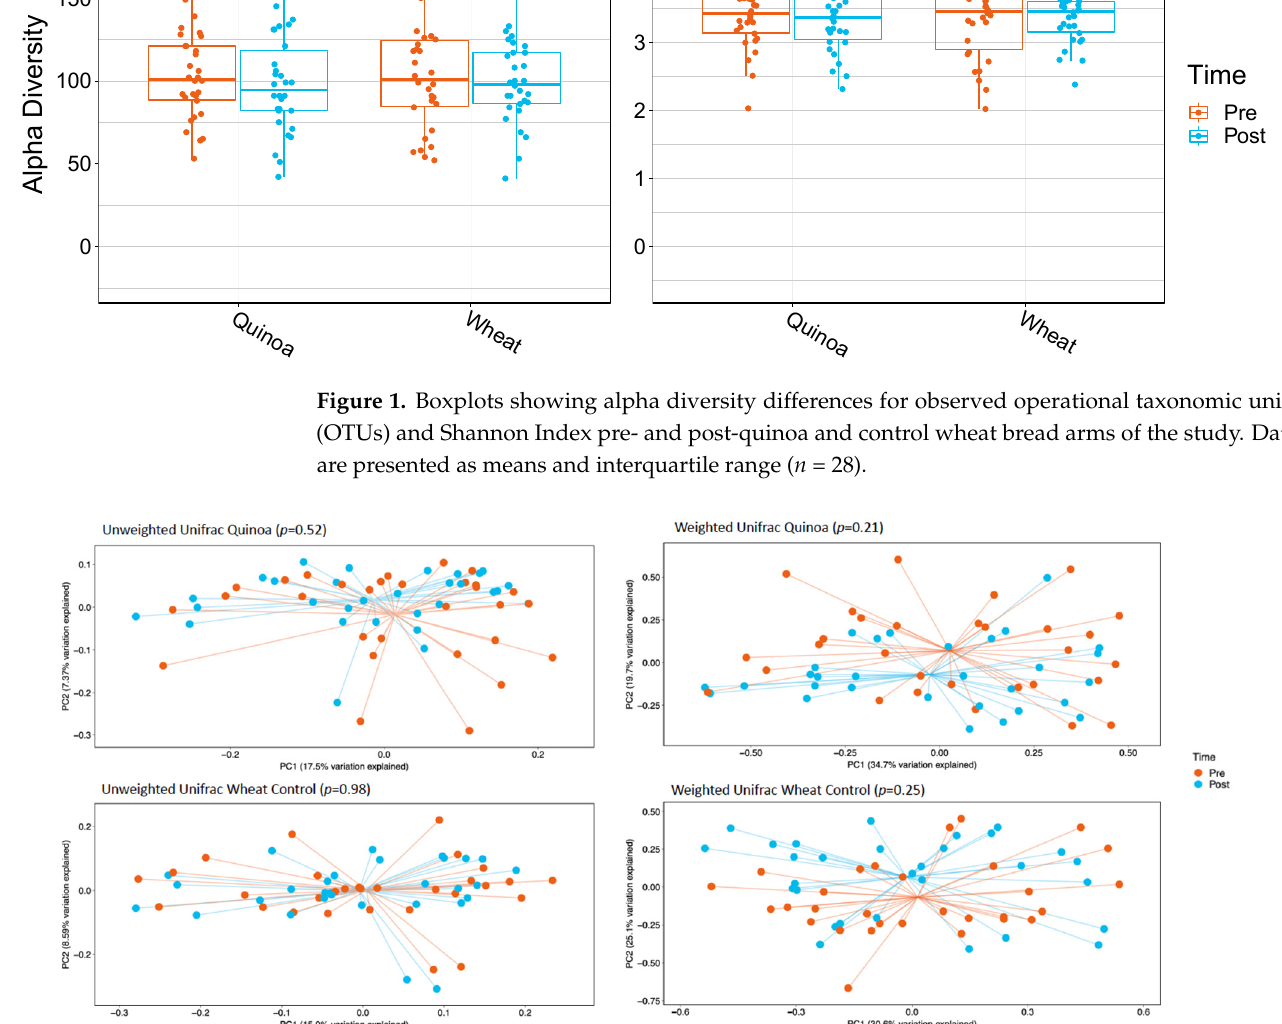
Figure 2. Principle co-ordinate analysis (PcoA) of unweighted UniFrac analysis and weighted UniFrac analysis pre- (baseline) and post-consumption (post) for quinoa and control wheat bread pre baseline and week 4.